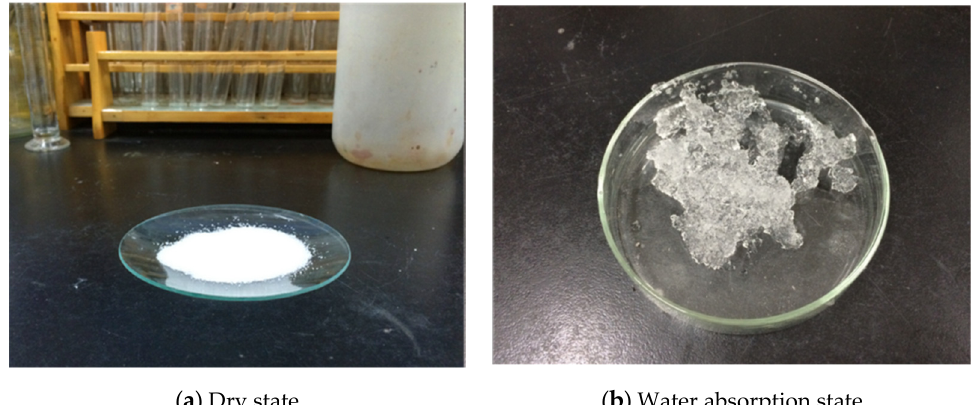
Figure 2. Superabsorbent polymers.